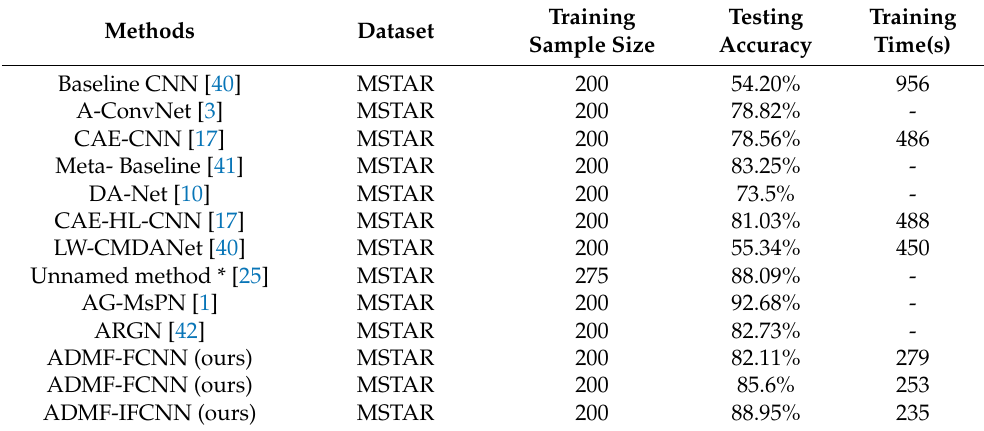
Figure 16. SSDD data sample: ( a ) original ship image; ( b ) result of ADMF method. Table 6. Comparison with the latest SAR recognition methods on MSTAR data